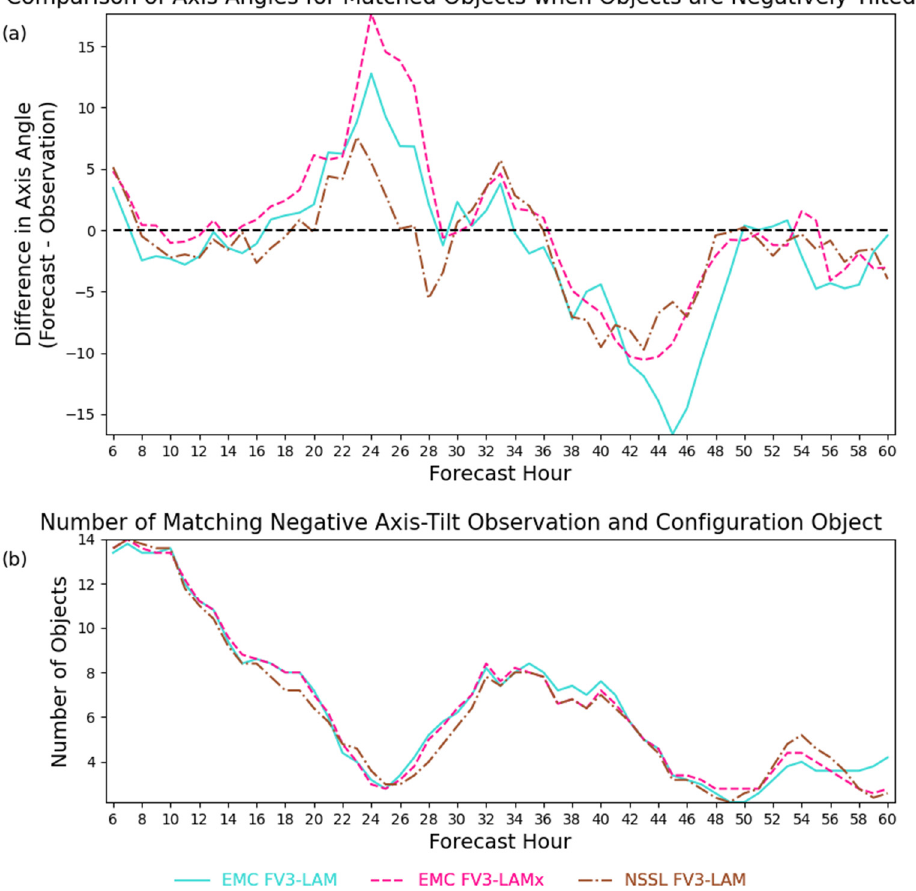
Figure 10. ( a ) Difference in axis angles for matching objects when both the observation and forecast objects have a negative axis angle. ( b ) Number of matched object pairs where both the observation and forecast objects have a negative axis angle.